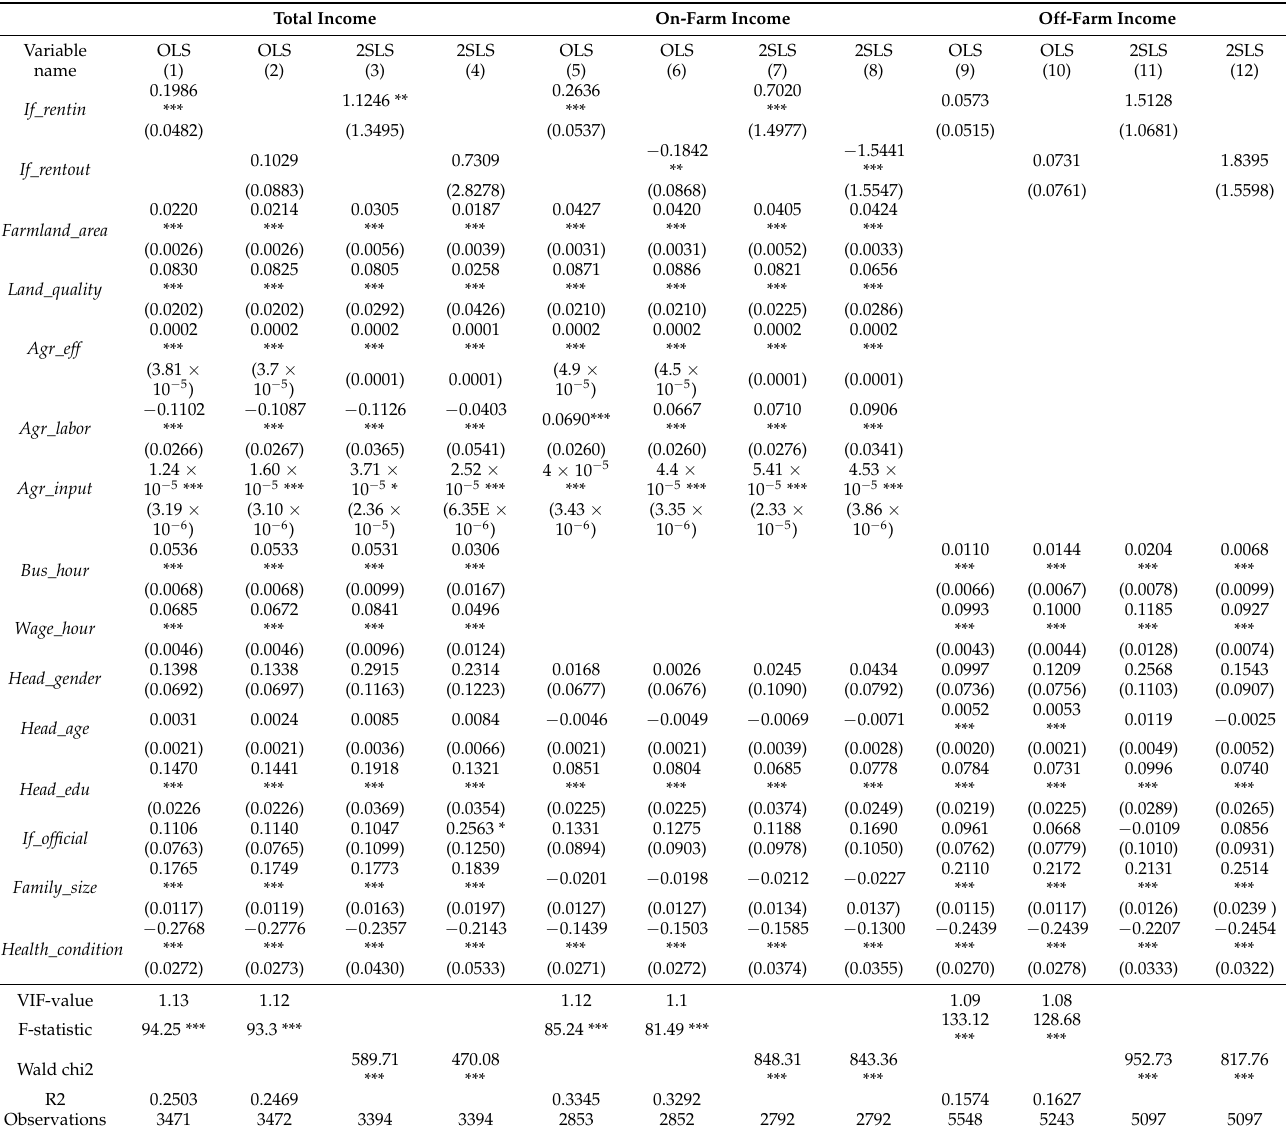
Table 4. The effects of farmland rental participation on household